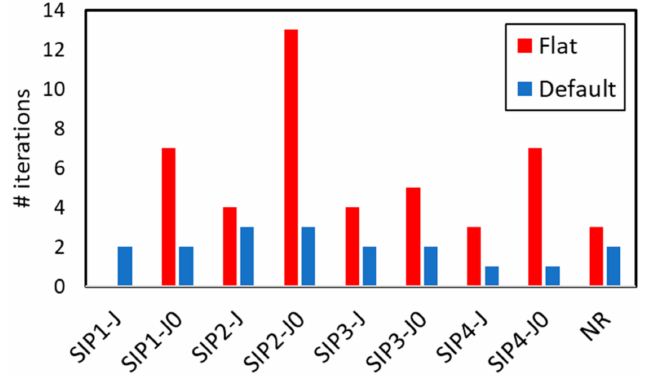
Figure 11. Total iterations employed in case3012wp with different solvers considering a flat start and the default starter provided in